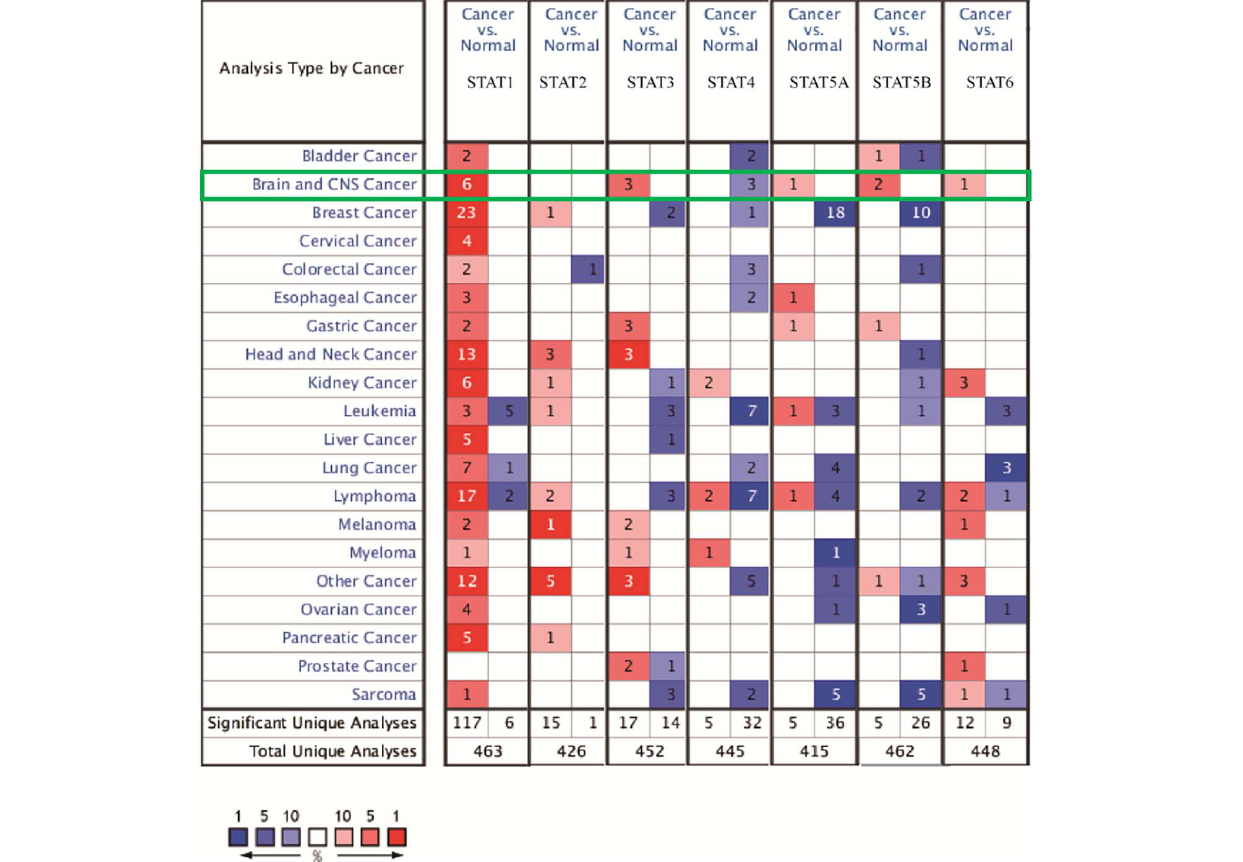
Frontiers in Genetics |